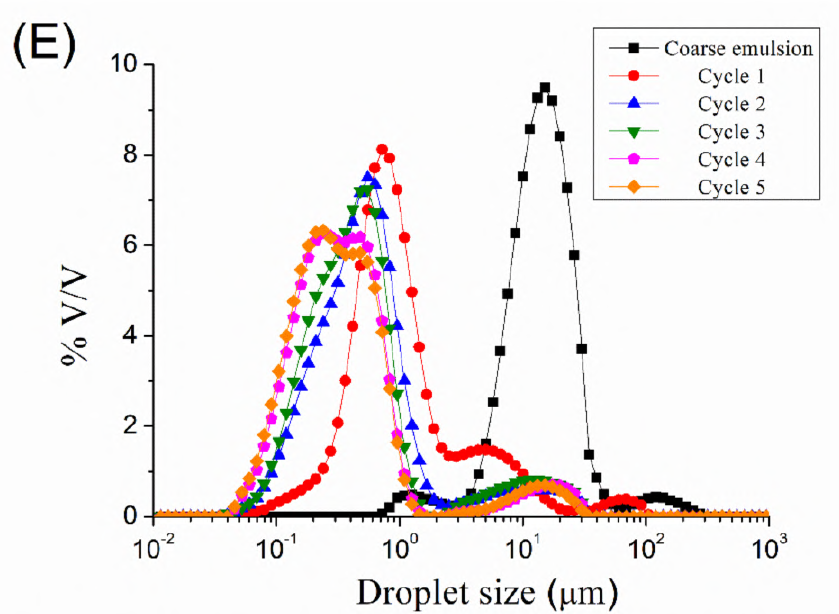
Figure 1. ( A ) Droplet size distributions for emulsions processed by microfluidization at 5000 psi as a function of the number of cycles. ( B ) Droplet size distributions for emulsions processed by microfluidization at 10,000 psi as a function of the number of cycles. ( C ) Droplet size distributions for emulsions processed by microfluidization at 15,000 psi as a function of the number of cycles. ( D ) Droplet size distributions for emulsions processed by microfluidization at 20,000 psi as a function of the number of cycles. ( E ) Droplet size distributions for emulsions processed by microfluidization at 25,000 psi as a function of the number of